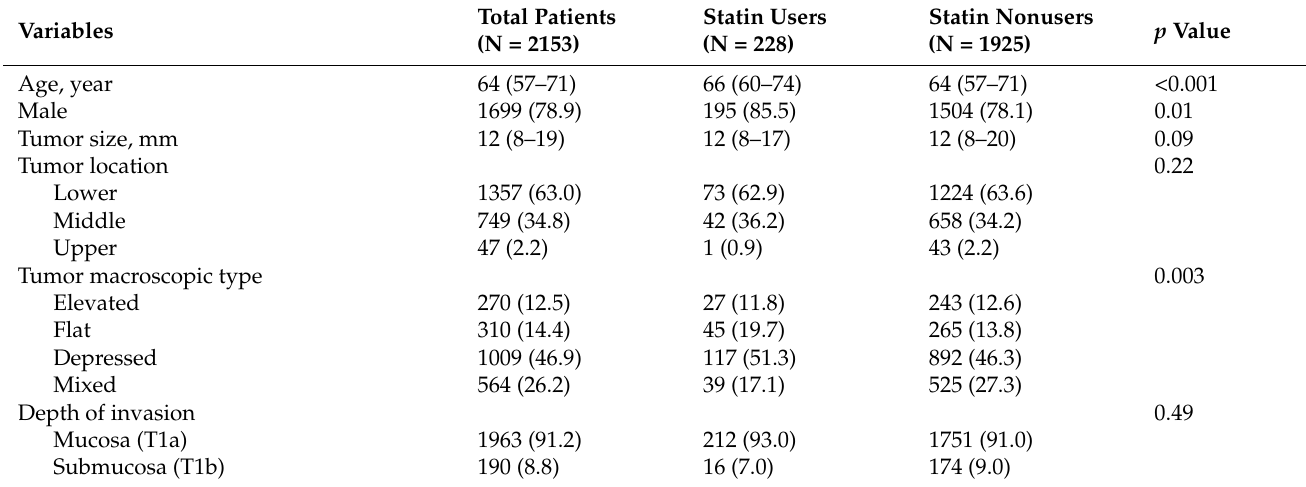
Table 1. Baseline characteristics of the study